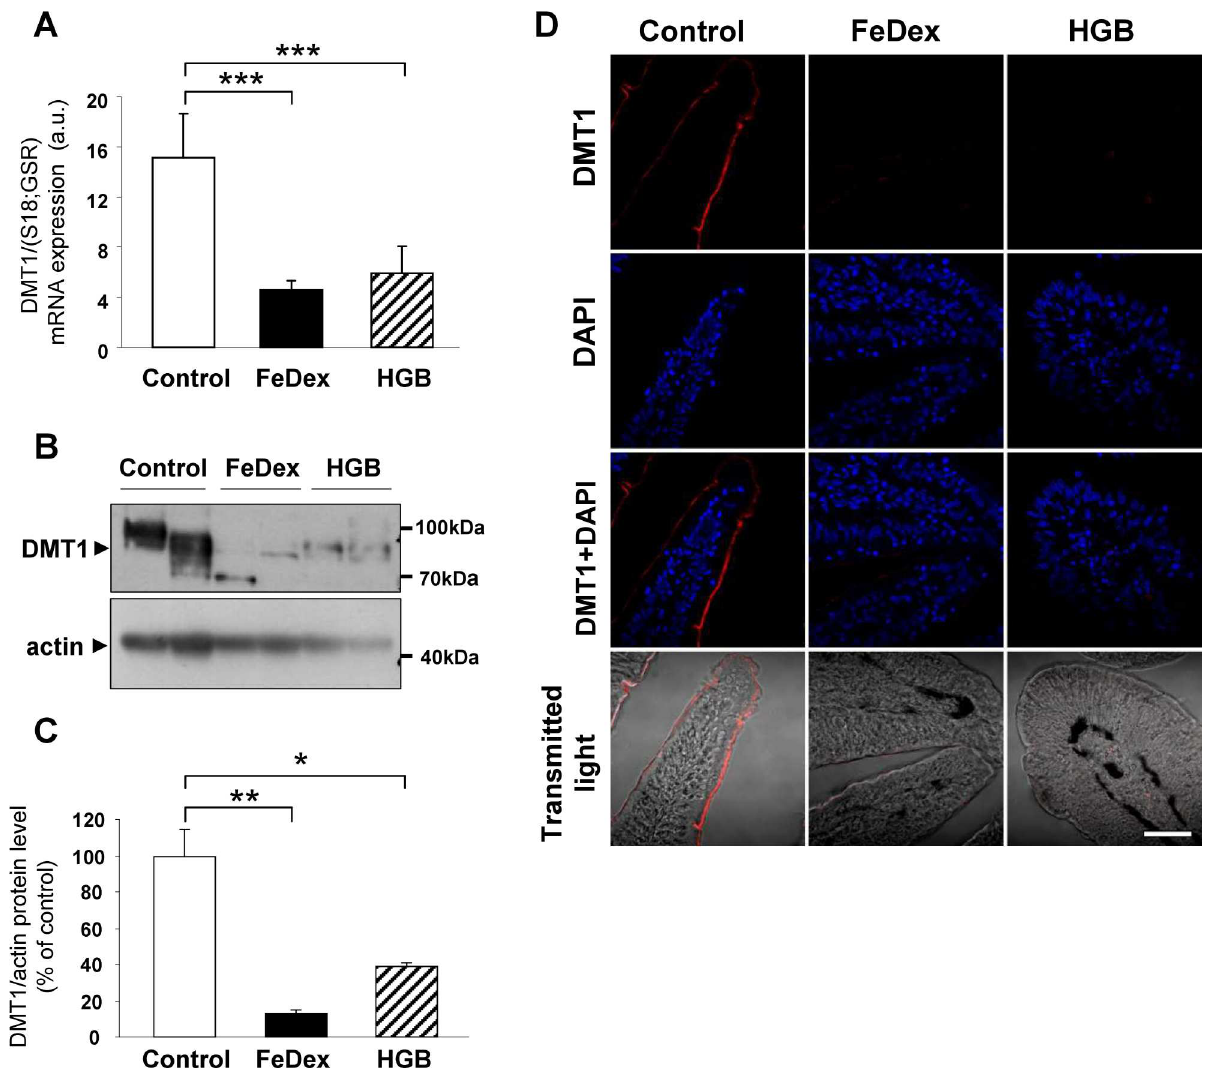
Fig 1. Reduced expression of DMT1 in piglets supplemented with FeDex and fed a hemoglobin (HGB)-enriched diet. (A) RT-qPCR analysisof DMT1 mRNA expression. The histogram displaysDMT1 mRNA levels in arbitrary units (means ± S.D., n = 7). (B and C) Western blot analysisof DMT1 protein levels in membranefractions preparedfrom duodenalscrapings.A representative immunoblot is shown (B) . ImmunolabelledDMT1 bands from separate blots performed on scrapingsisolatedfrom 6 pigletswere quantified using a MolecularImager, and DMT1 protein levels (means ± S.D.) are plotted in arbitrary units (C) . (D) Immunofluorescentstaining of DMT1 in the duodenum. To confirm the specificity of DMT1 detection, piglet duodenumsections were incubatedwith only the secondaryantibody. No DMT1 stainingwas detected in these negativecontrols. Counterstaining of nuclei was performed with DAPI. Duodenummorphology is shown in transmitted light.